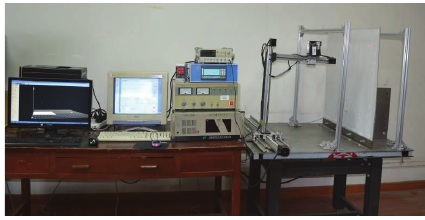
Figure 13: Photo of the experimental